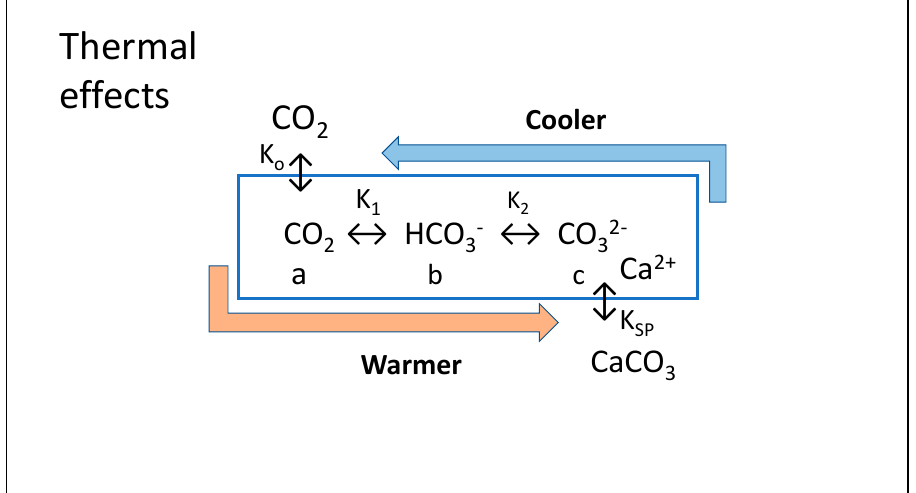
Figure 2. Variations in thermodynamic constants with temperature are proposed to favor precipitation of CaCO 3 in summer with pH falling, coupled with absorption of CO 2 from the atmosphere from spring. In autumn and winter, the process is reversed, dissolving calcite (x moles) and releasing CO 2 to air (y moles), with calcite dissolution in colder water exceeding CO 2 emissions (x > y).